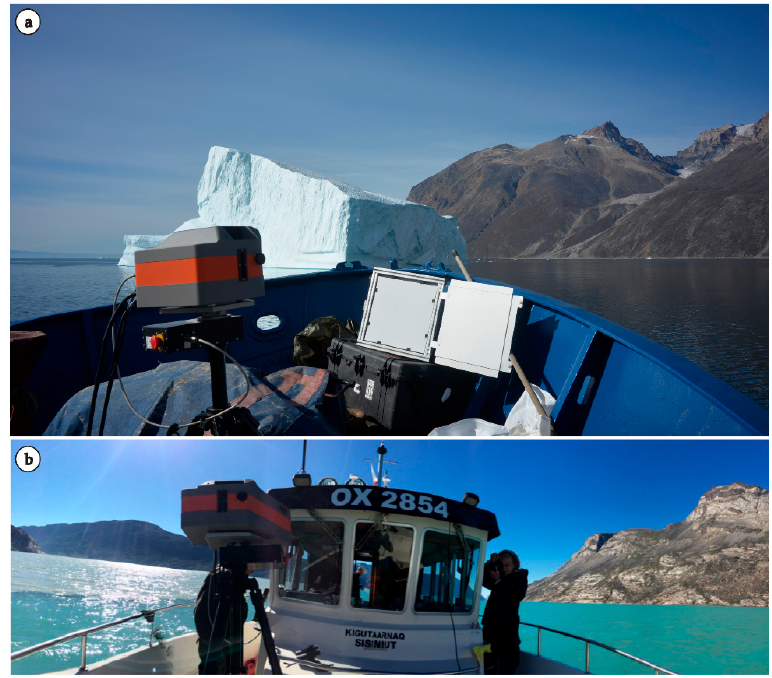
Figure 2. Setup used to collect hyperspectral data in the: ( a ) Karrat area; and ( b ) Søndre Strømfjord region.